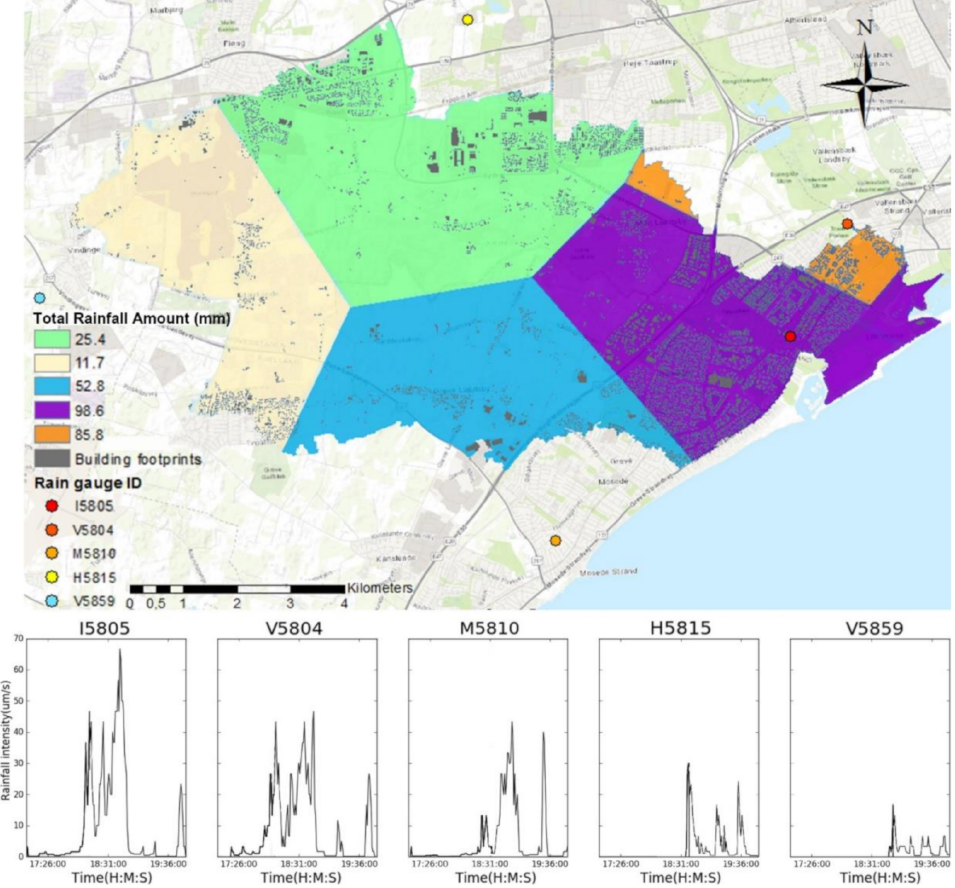
Figure 7. Spatial rainfall distribution based on Thiessen polygons and corresponding time-series rain gauge